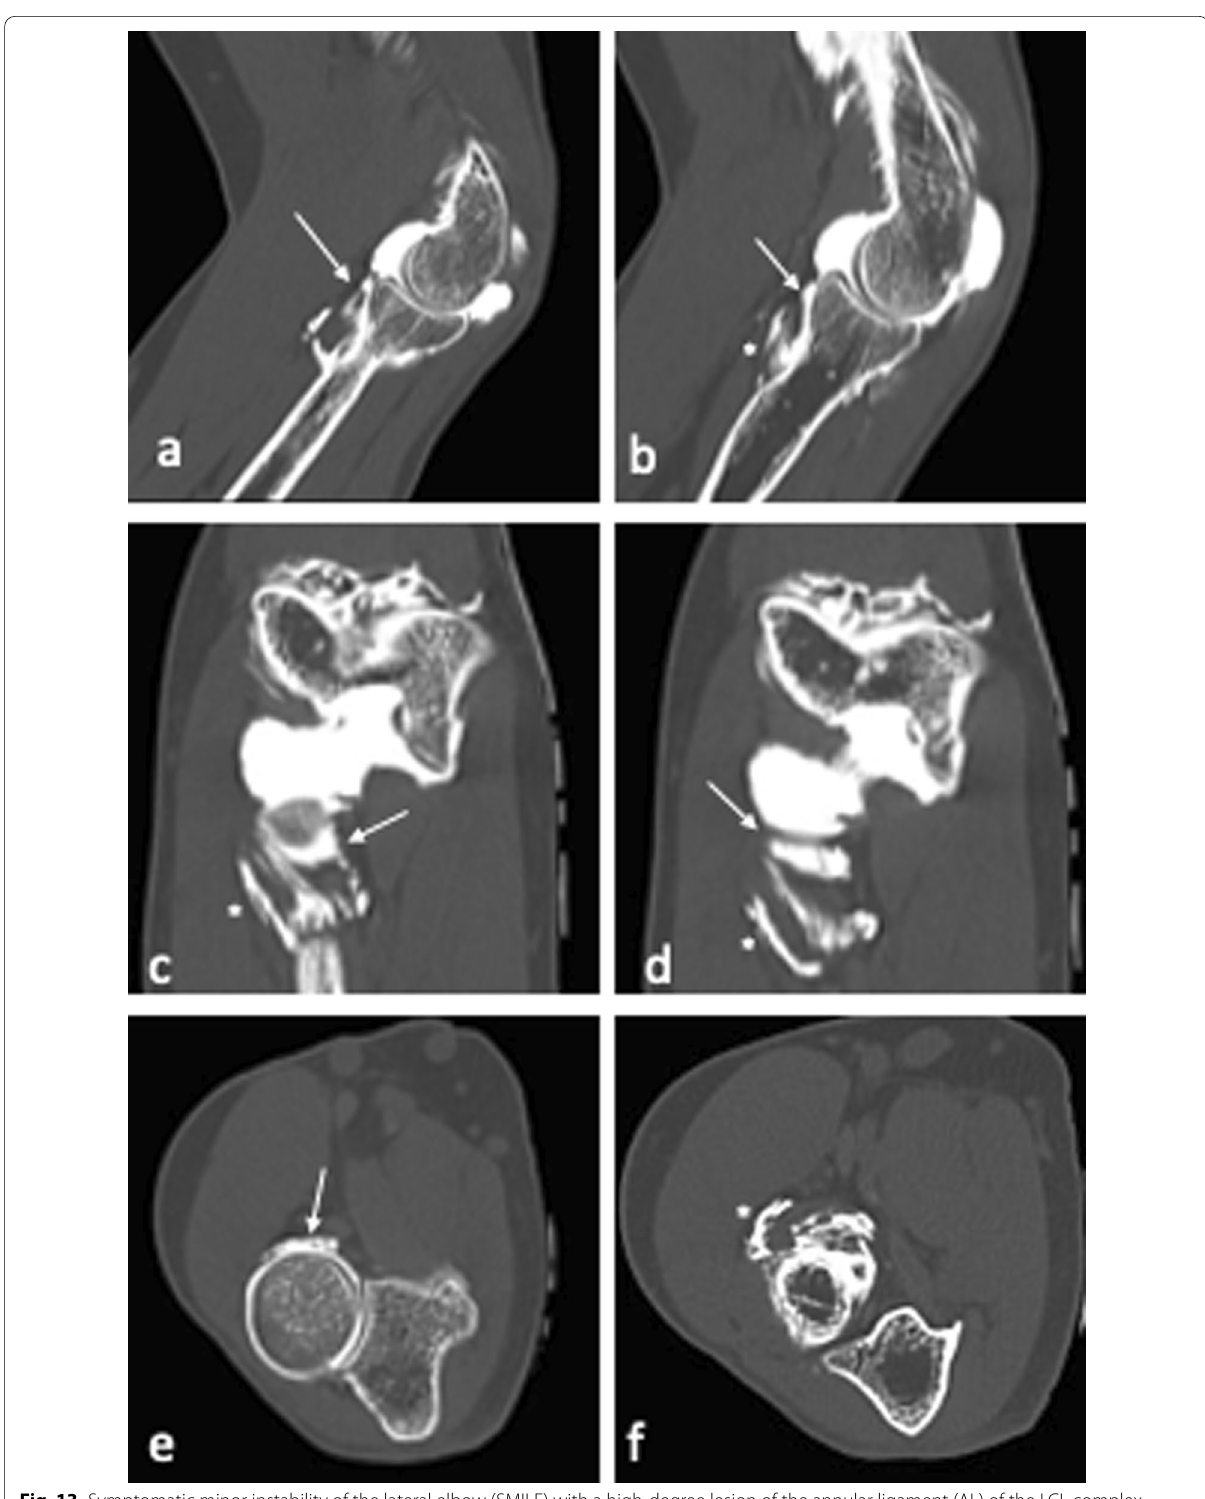
Fig. 13 Symptomatic minor instability of the lateral elbow (SMILE) with a high-degree lesion of the annular ligament (AL) of the LCL complex. Consecutive sagittal ( a , b ), coronal ( c , d ) and axial ( e , f ) CT-arthrography scans highlight the ruptured AL (white arrows) and display extra-articular leakage (asterisks) through the damaged articular